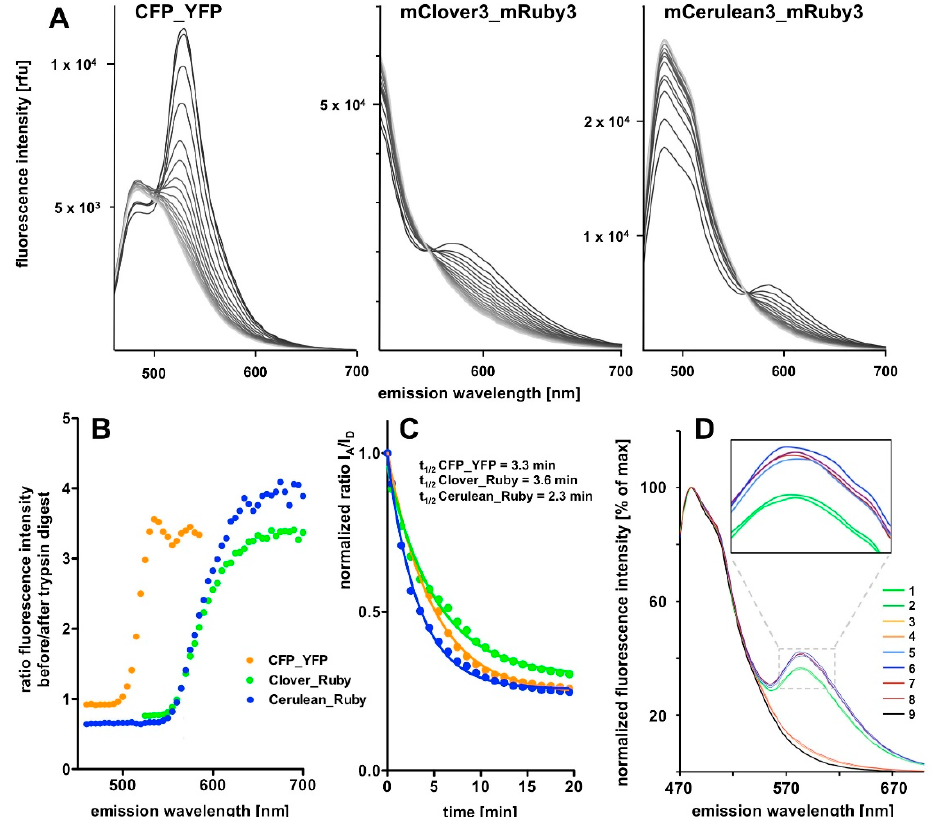
Figure 4. Time course of the tryptic digest of the FRET fusion proteins. ( A ) The FRET signal decay in response to tryptic digestion over time for the three FRET constructs. The excitation wavelengths were 425 nm for the recording of the CFP_YFP and the mCerulean3_mRuby3 spectra and 490 nm for the mClover3_mRuby3 spectra. FRET signals are gradually reduced over time, while the peak/intensity in the left part of the spectrum is increased. The absolute change in FRET signal decreases in the order CFP_YFP, Clover_Ruby to Cerulean_Ruby, as does the remaining residual fluorescence after the trypsin digest; the latter indicating reduced bleed-through problems. On plotting the ratio of fluorescence intensities before the start and after completion of the trypsin digest as a function of wavelength ( B ), it becomes obvious that the mCerulean3_mRuby3 pair shows the biggest amplitude. This is less evident when plotting the I A /I D ratio over time ( C ) because the signal to noise ratio further improves with longer wavelength beyond I A in case of the Cerulean_Ruby and the Clover_Ruby FRET constructs, while this is not the case for the CFP_YFP pair ( B ). ( D ) Stability and reproducibility controls: two similar experiments were performed on separate days and compared after normalization of the fluorescence intensity signals to the maximum of the respective curve. 1 and 2 (green lines): mCerulean3_mRuby3 before tryptic digest; 3 and 4 (orange lines) mCerulean3_mRuby3 after tryptic digest; 5–8: the same set of experiments with the mCerulean3_mRuby3 construct containing the short, trypsin-resistant linker (note the higher FRET efficiency of the construct and the lack of FRET signal decay after trypsin incubation (dark red lines); 9: mCerulean3